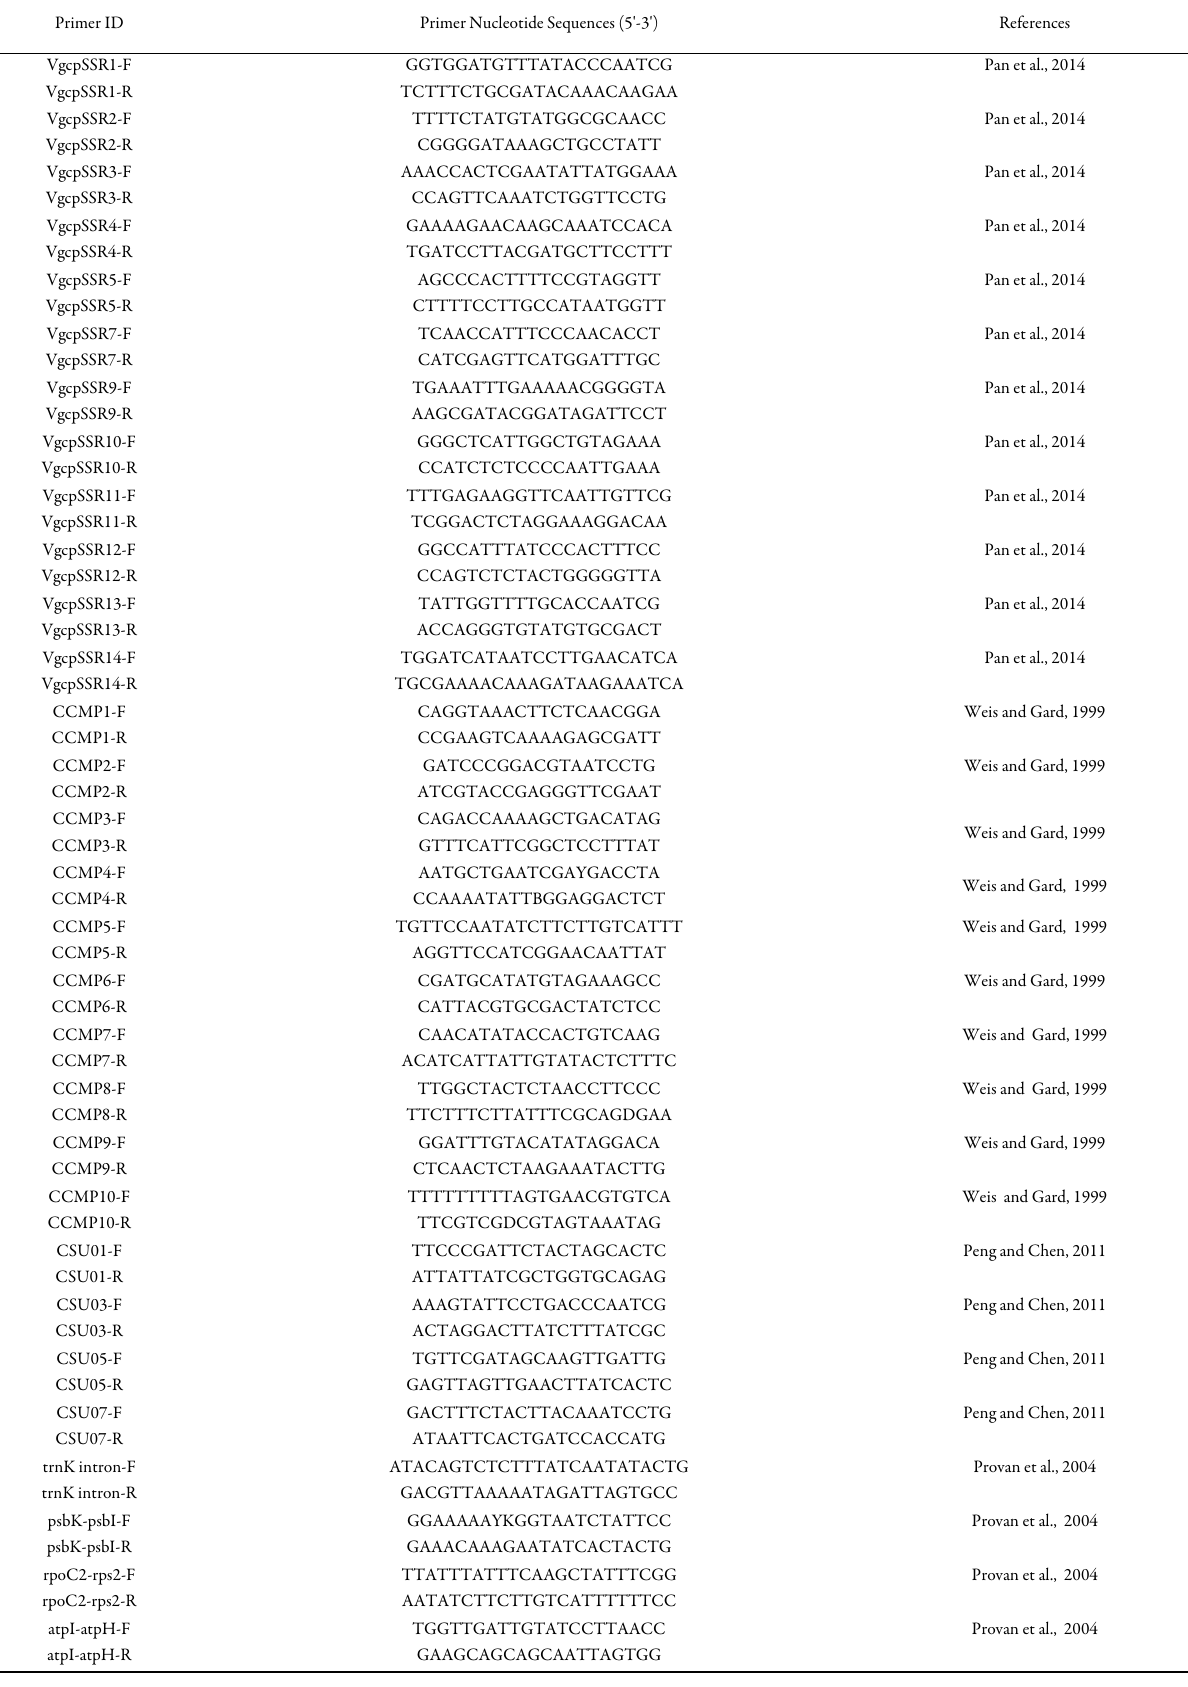
Table 8. List of cpSSR primers screened with their nucleotide sequence and references Primer